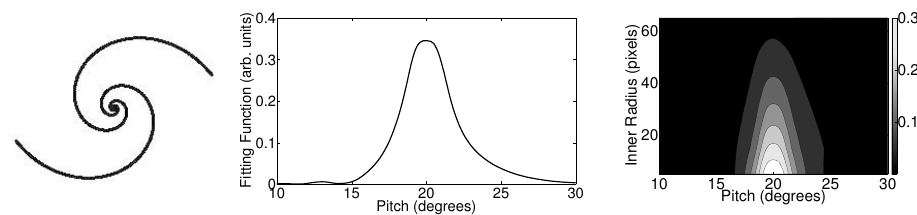
Figure 3. Spirality’s measurement of the synthetic two-arm spiral of pitch angle 20 ◦ , shown in the left panel . Center : Fitting function vs. pitch angle for a measurement annulus with inner radius 5 pixels, or 5% of the outer radius. The outer radius of the measurement annulus is approximately equal to the outer radius of the spiral. Right : Fitting function vs. pitch angle and measurement annulus inner radius. Note that the center panel is a cross section of the right panel. Spirality’s measurement gives a best-fit pitch of 19.97 ◦ ± 0.13 ◦ .